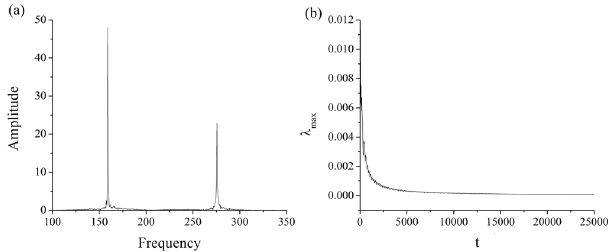
Fig. 6. Fourier power spectrum (a) and maximal Lyapunov expo- nent (b) for time series in Fig. 5: (a) Two peaks in the power spec- trum indicate the appearance of quasiperiodic motion. (b) The max- imal Lyapunov exponent converges approximately to λ ≈ 0. Note that in (b) time t is expressed in the units of iteration